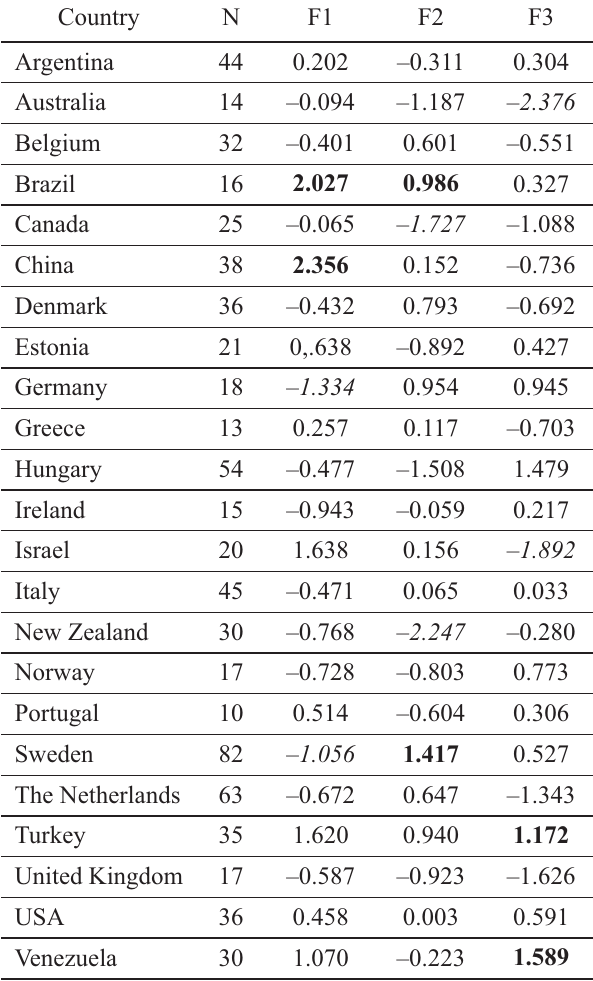
Table 1. Values of 3 manufacturing factors